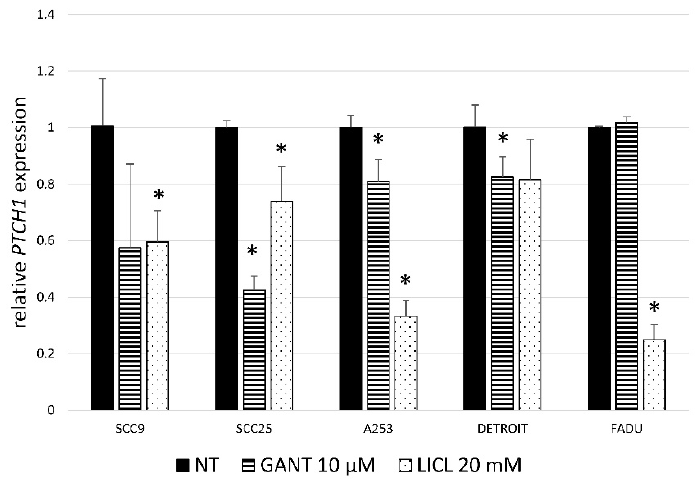
Figure 2. Relative gene expression of PTCH1 . PTCH1 , the target gene of the HH-GLI signaling 24h after GANT61 or LiCl treatment. LiCl downregulates PTCH1 expression in 4 / 5 HNSCC cell lines, pathway, 24h after GANT61 or LiCl treatment. LiCl downregulates PTCH1 expression in 4/5 HNSCC and GANT61 in 3 / 5 lines. * denotes a statistically significant di ff erence from non-treated (NT) cells cell lines, and GANT61 in 3/5 lines. * denotes a statistically significant difference from non-treated ( p < (NT) cells ( p < 0.05).